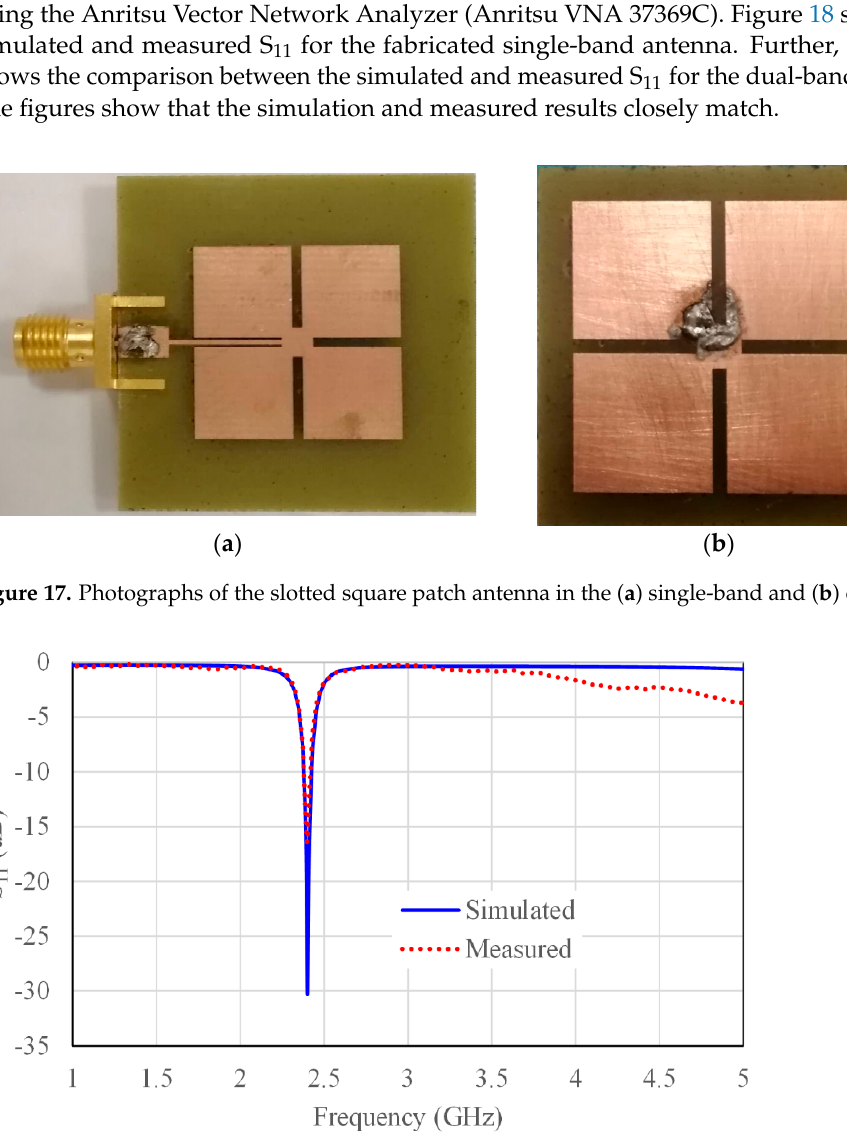
Figure 16. The simulated S 11 of the modified single band antenna.